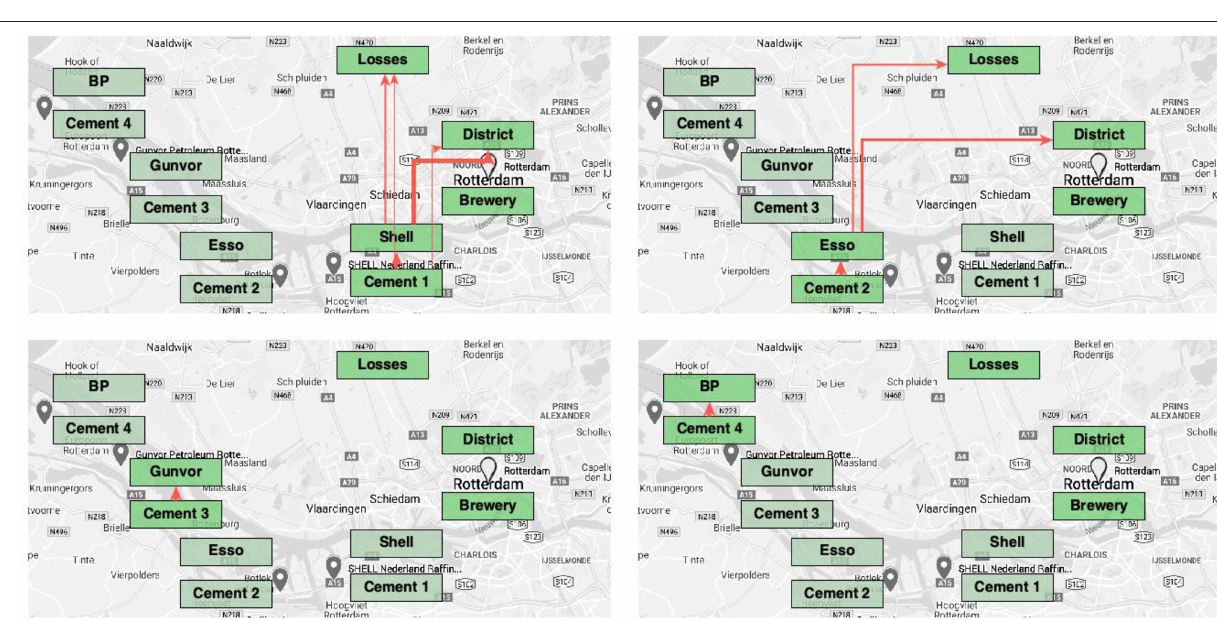
FIGURE 13 | Heat transfer and losses, refinery/cement plant couples considered